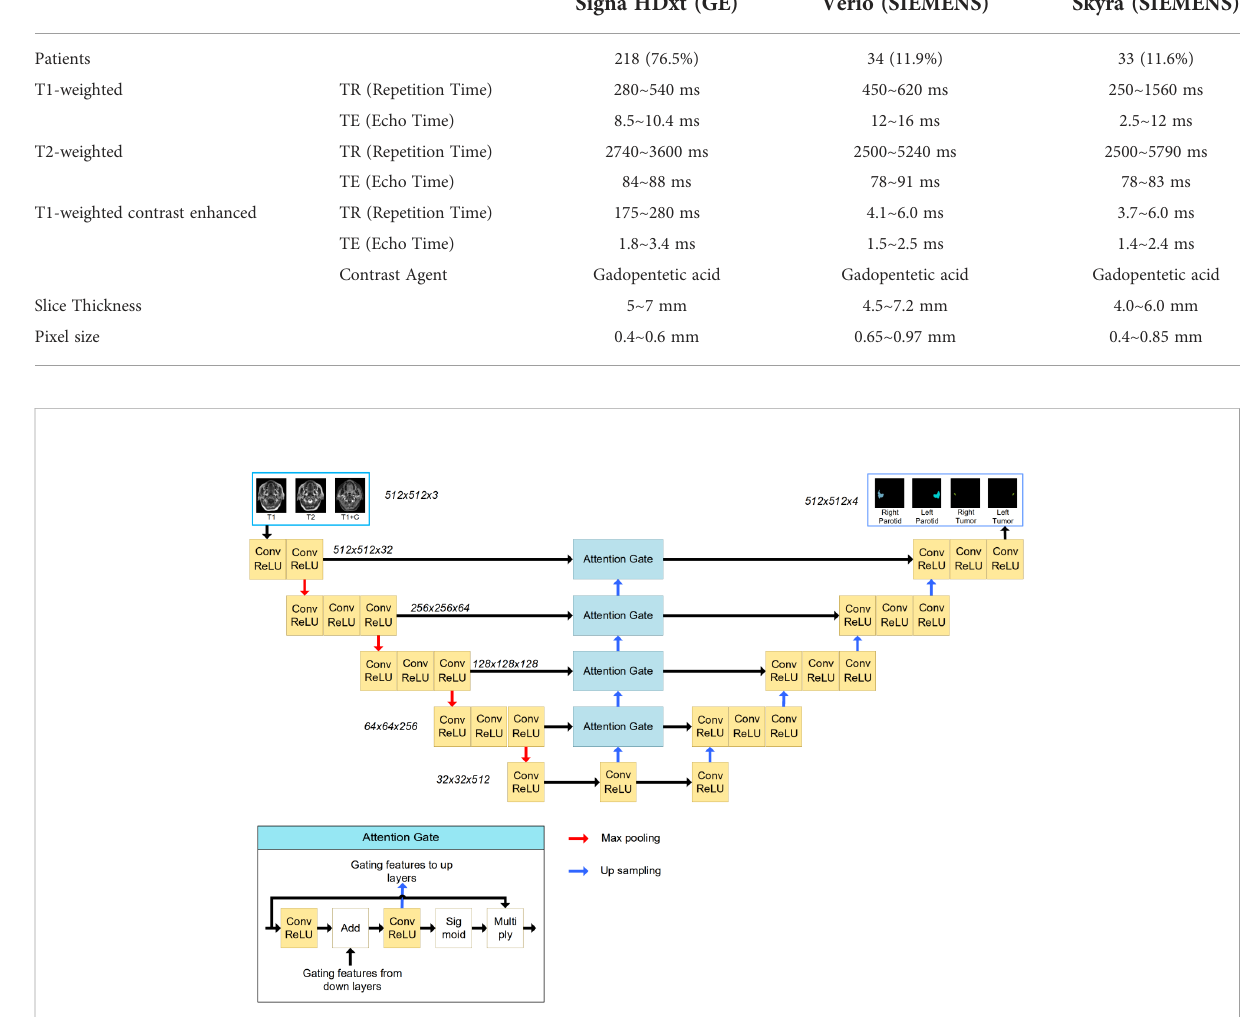
FIGURE 2 The structure ofthe attention-based U-Net. The input of the network is three MR images, and the output of the network is the four segmentations. The attention gate structureis shown in the